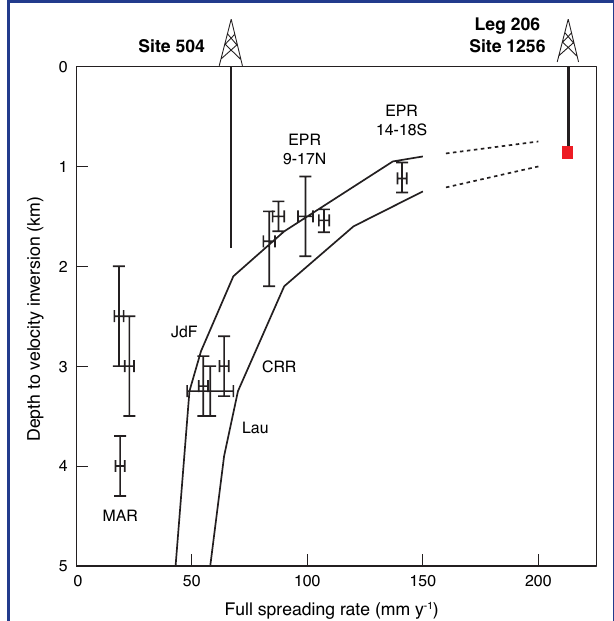
Figure 2. Depth to axial low-velocity zone plotted against spreading rate (modified from Carbotte et al. (1997). Depth versus spreading rate predictions from two models of Phipps Morgan and Chen (1993) are shown, extrapolated subjectively to 200 mm y -1 (dashed lines). Penetration to date in Holes 504B and 1256D is shown by solid vertical lines, with the depth at which gabbros were intersected indicated by the red box. Following core descriptions, a thickness of ~300 m of off-axis lavas is shown for Hole 1256D and assumed for Hole 504B. EPR = East Pacific Rise, JdF = Juan de Fuca Ridge, Lau = Valu Fa Ridge in Lau Basin, CRR = Costa Rica